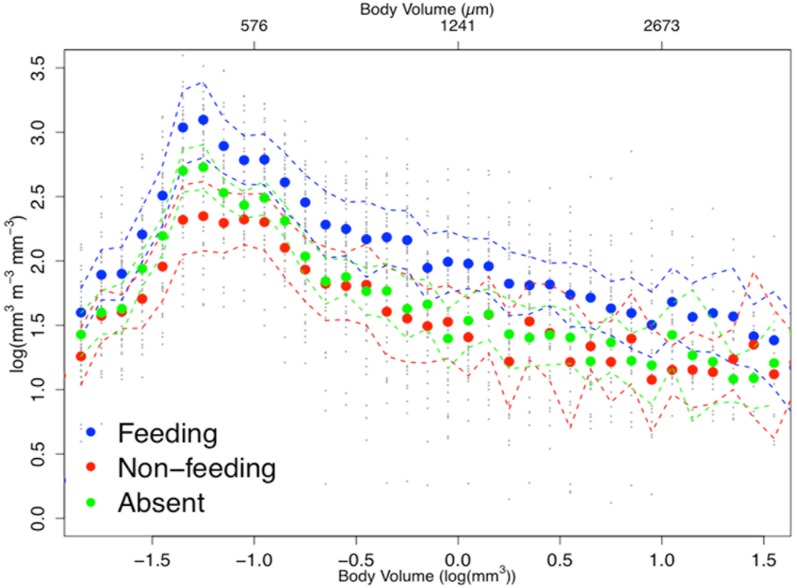
Zooplankton size spectra analysis.Normalised Biovolume Size Spectra of the zooplankton community showing higher biovolume across all size classes (body volume intervals) when reef manta rays are feeding (n = 17) than when non-feeding (n = 12) or absent (n = 21). Dashed lines represent 95% confidence intervals.